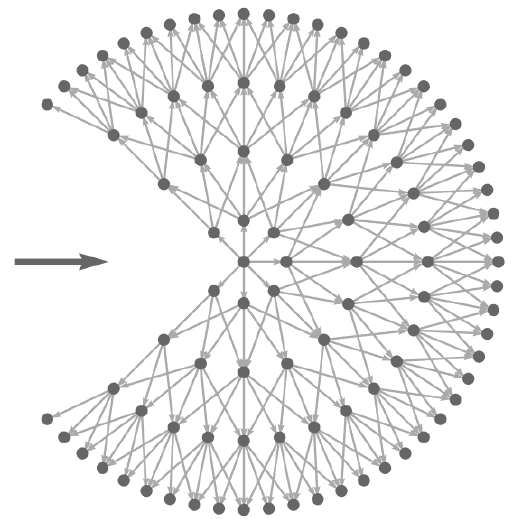
Figure 3. Example of local graph in graph-based growing contours. The large horizontal arrow indicates the direction of movement.